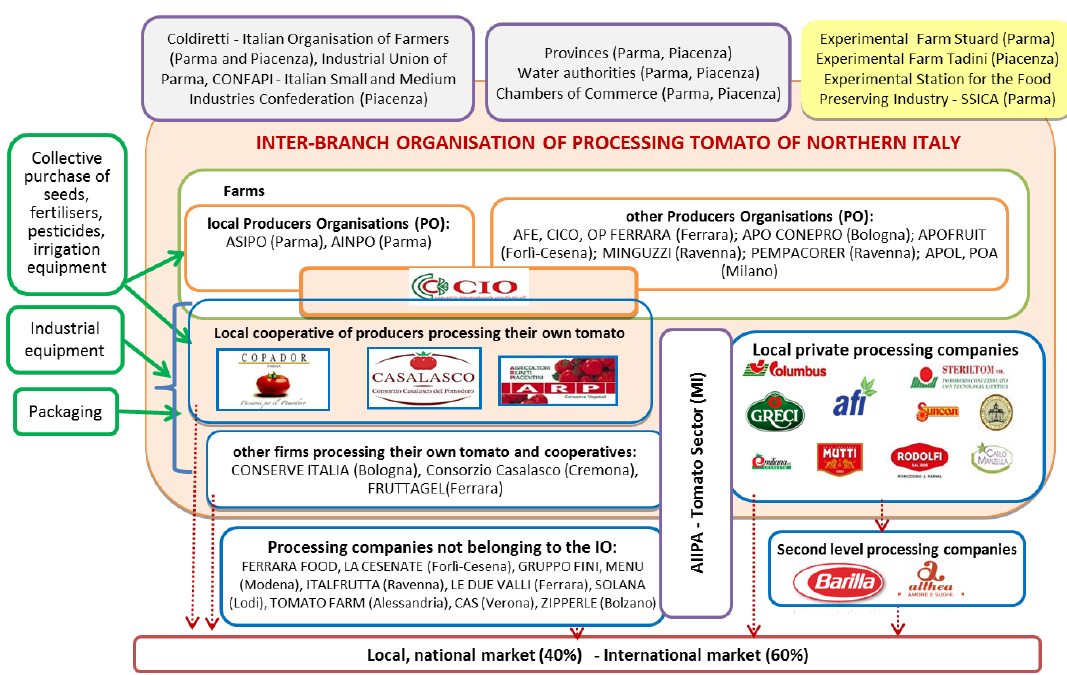
Figure 2. Governance structure of the processed tomato of northern Italy (adapted from Daraio, 2014) [16].